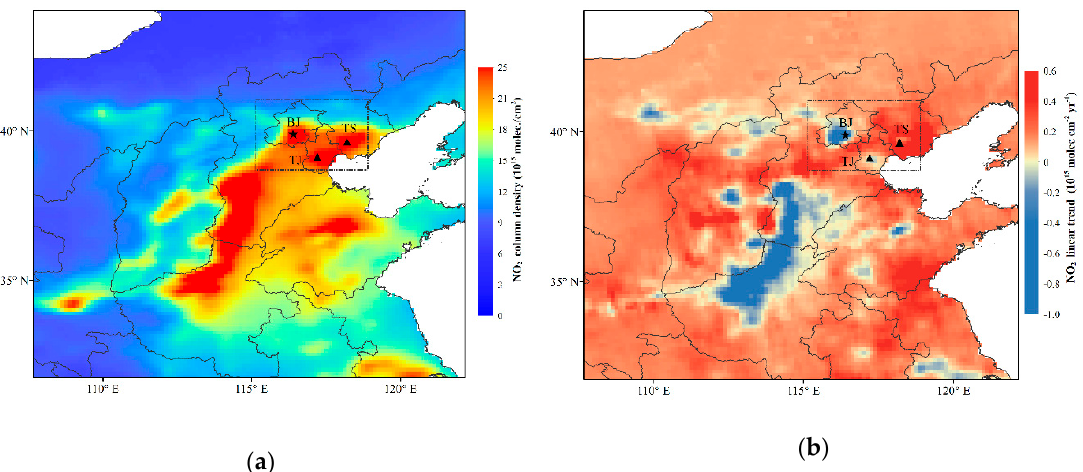
Figure 5. ( a ) Tropospheric NO 2 VCD in Beijing and Jing–Jin–Tang averaged from 2005 to 2018 (unit: 10 15 molec cm − 2 ) and ( b ) tropospheric NO 2 VCD linear trends in Beijing and Jing–Jin–Tang from 2005 to 2018 (unit: 10 15 molec cm − 2 year − 1 ). The black boxes denote the locations of Beijing and the Jing–Jin–Tang region. Triangles indicate the three cities (Beijing, Tangshan and Tianjin).